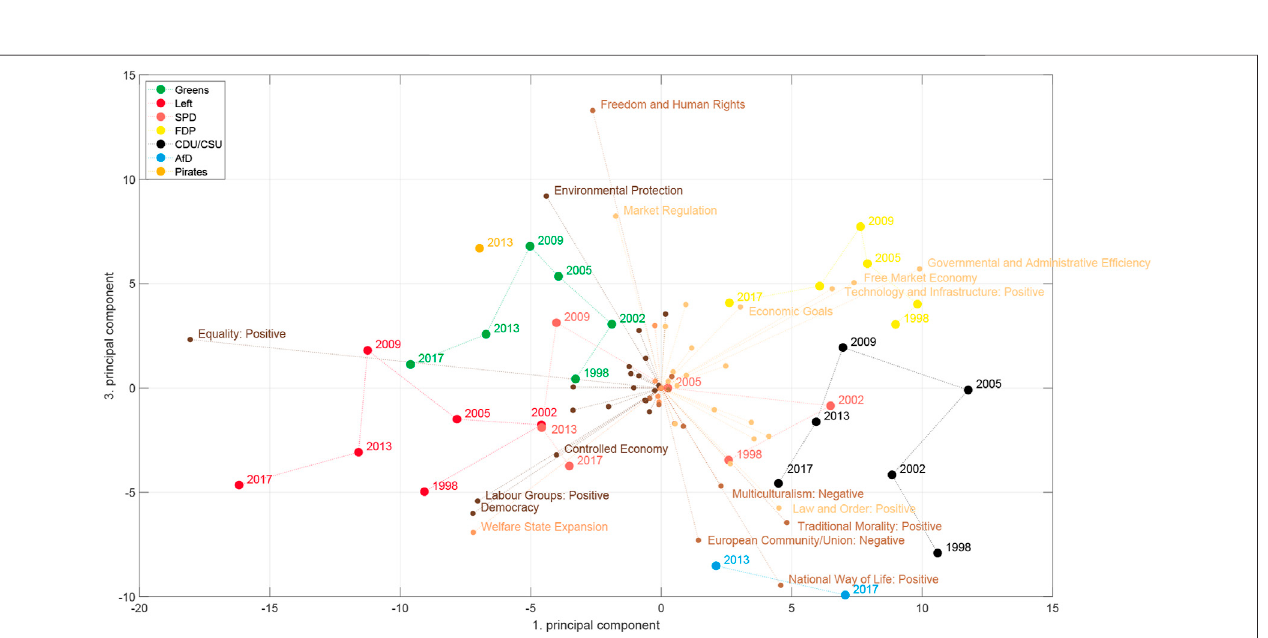
Frontiers in Big Data |